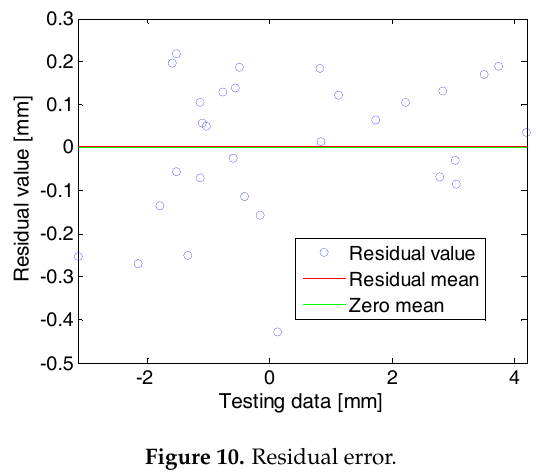
Figure 10. Residual error.